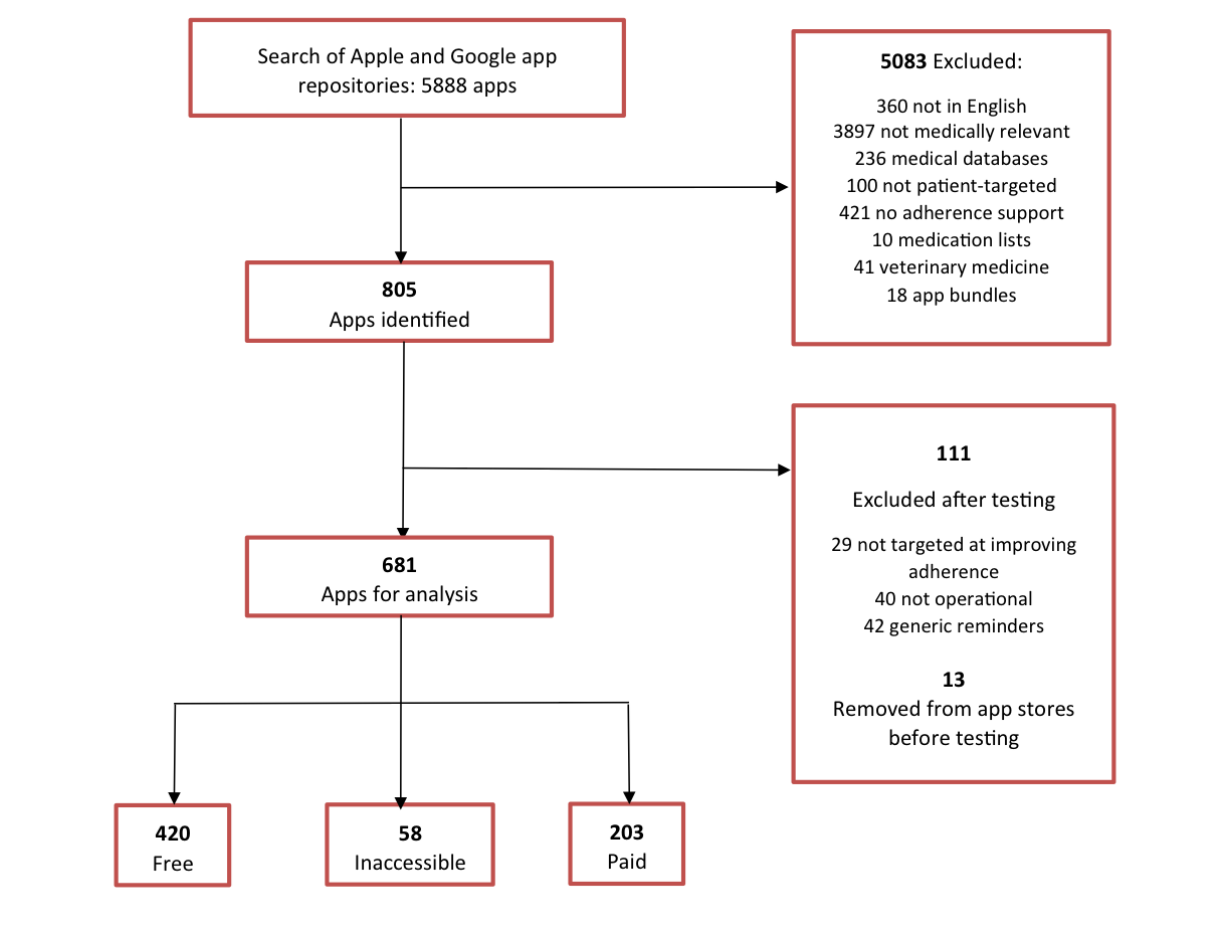
Figure 1. Flowchart of identification of